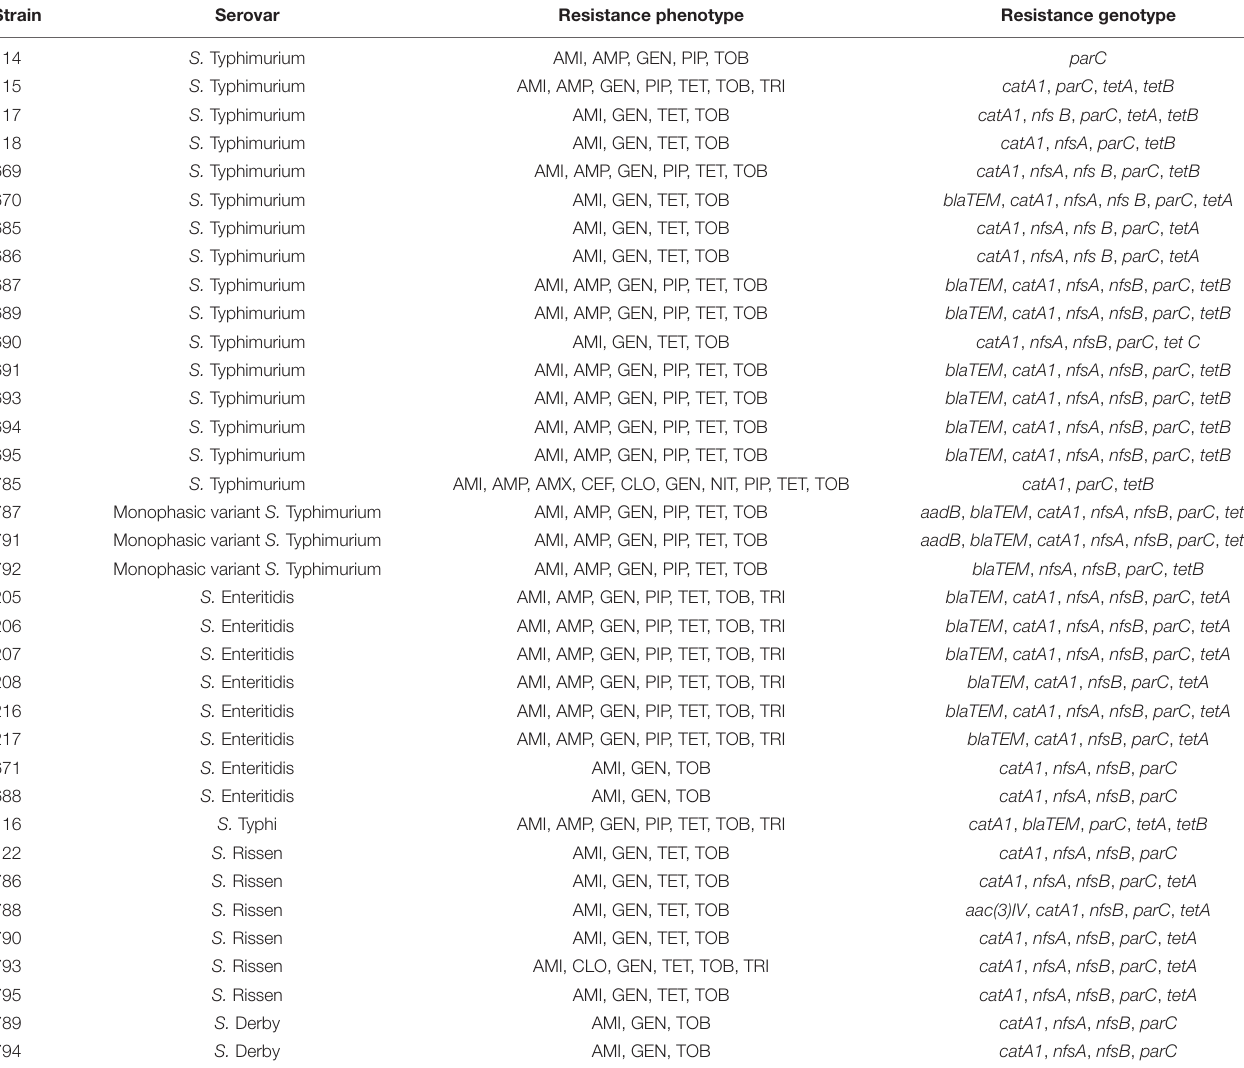
TABLE 2 | Overview of the antibiotic resistance shown by the 36 investigated isolates of Salmonella spp. Strain Serovar Resistance phenotype Resistance